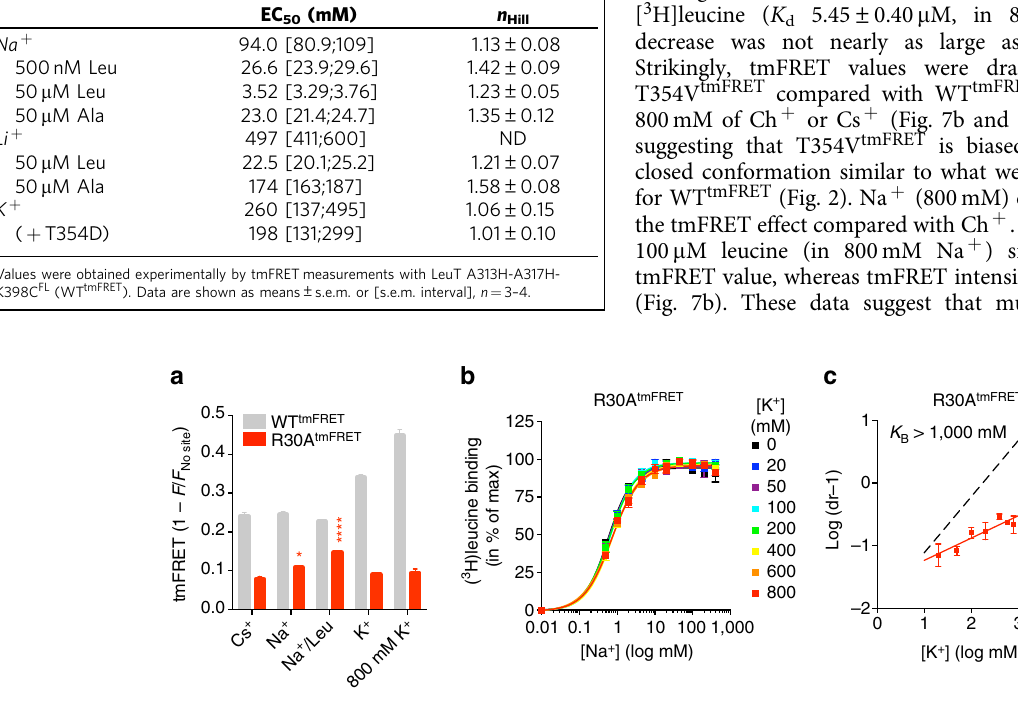
Figure 5 | K þ -binding is abolished in LeuT R30A. ( a ) tmFRET values between EL4 and TM10 obtained by tmFRET experiments with R30A tmFRET are consistent with an outward-open state for the Cs þ condition (0.079 ± 0.007; means ± s.e.m., n ¼ 3). Na þ alone and together with leucine significantly increased tmFRET (0.108 ± 0.004 and 0.148 ± 0.004; means ± s.e.m., n ¼ 4 and 7, respectively). No significant change in quenching was detected in the presence of K þ . Ni 2 þ (5mM) experiments were carried out with 200mM of the indicated ions and 100 m M leucine (Na þ /Leu condition). * P o